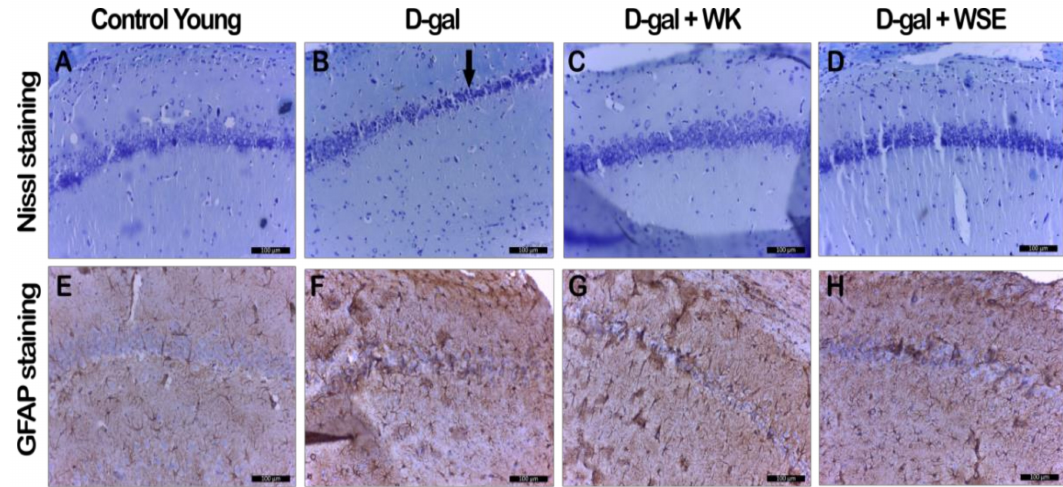
Figure 9. Histopathological and immunohistochemical changes observed in D-gal-induced aging rat groups in hippocampal CA1 region (D-gal—D-galactose; GFAP– glial fibrillary acidic protein; WK—walnut kernel; WSE—walnut septum extract). ( A – D ) Nissl staining; ( E – H ) GFAP staining.